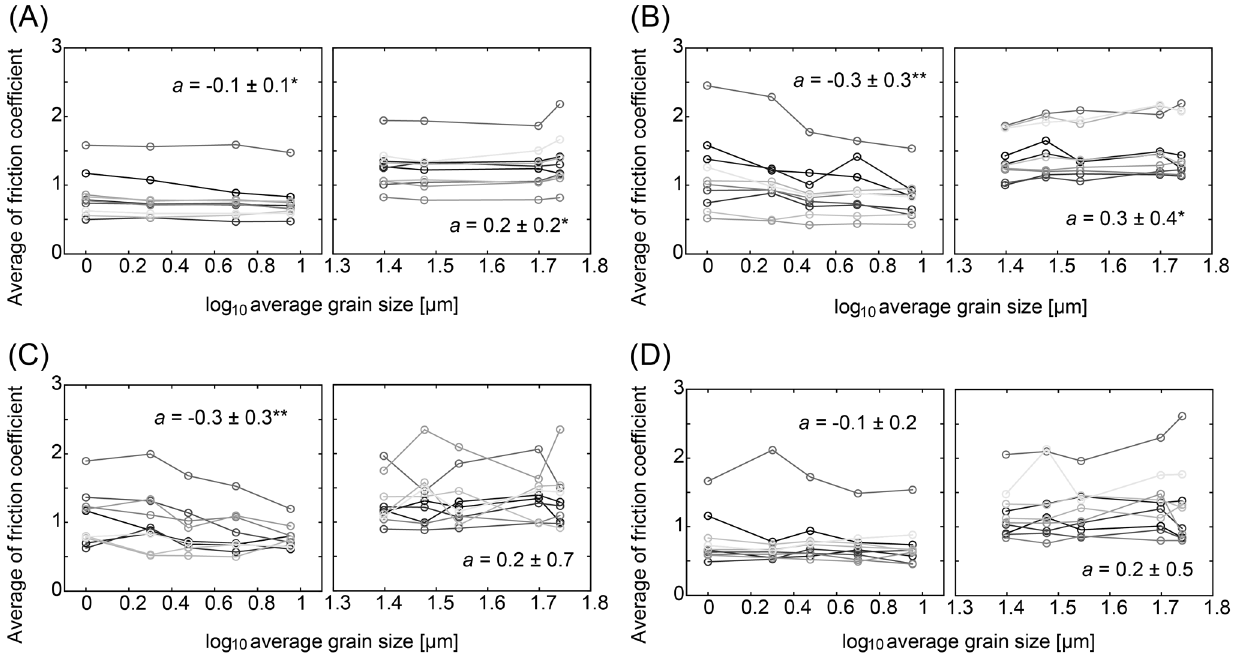
Figure 10. Relationship between friction coefficient and grain size of stimulus. The average of friction coefficients for each participant is shown. (A) Discrimination task. (B) Identification task. (C) 1 st control task. (D) 2 nd control task. Left panels indicate the results for the smooth stimuli and right panels for the rough stimuli. a is the average of the slopes and its standard deviation which were estimated for each participant. *indicates p , 0.05 and ** p , 0.01 with t -tests or Wilcoxon signed rank tests.